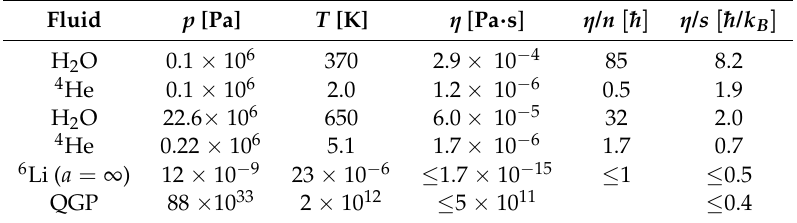
Figure 3. Examples of strongly correlated systems in thermodynamic equilibrium include complex plasmas, trapped ions, and the quark–gluon plasma (QGP) extending along the outer ( pink ) area, while dot shows the conditions at RHIC. The figure has been reproduced from Ref. [103]. Table 1. The viscosity η , the viscosity over density η / n ratio, and the viscosity over entropy density η / s ratio for several fluids at particular values of pressure p and temperature T (from Ref.